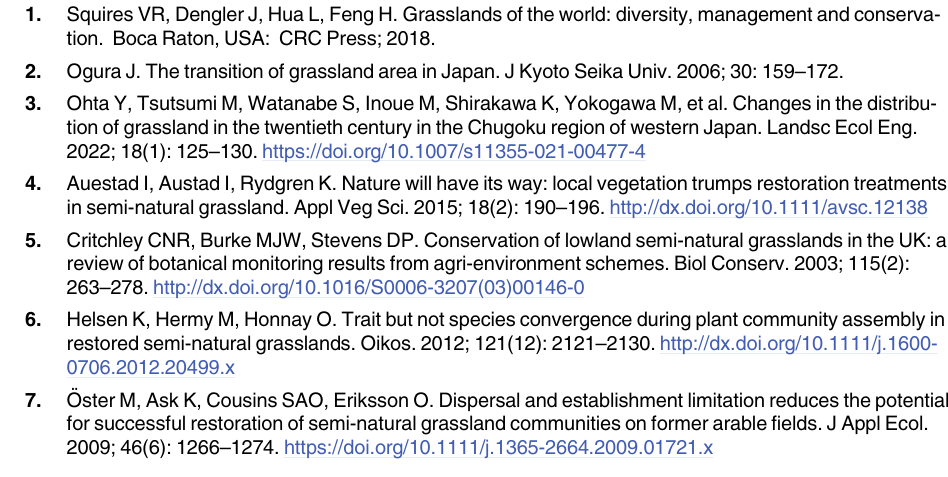
S2 Table. Vegetation data in the two pastures in 2019. Plant species recorded in each quadrat in 2019, and their covers (%). S3 Table. Chemical properties of surface (0–5 cm depth) soil in each quadrat in